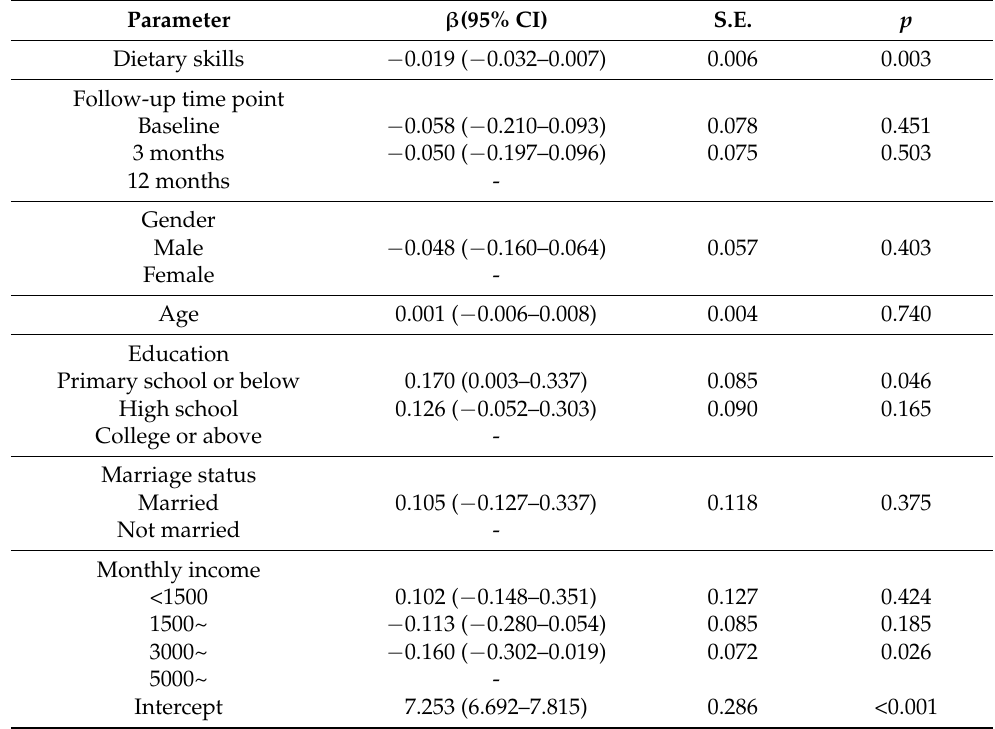
Table 5. The influence of dietary skills on blood